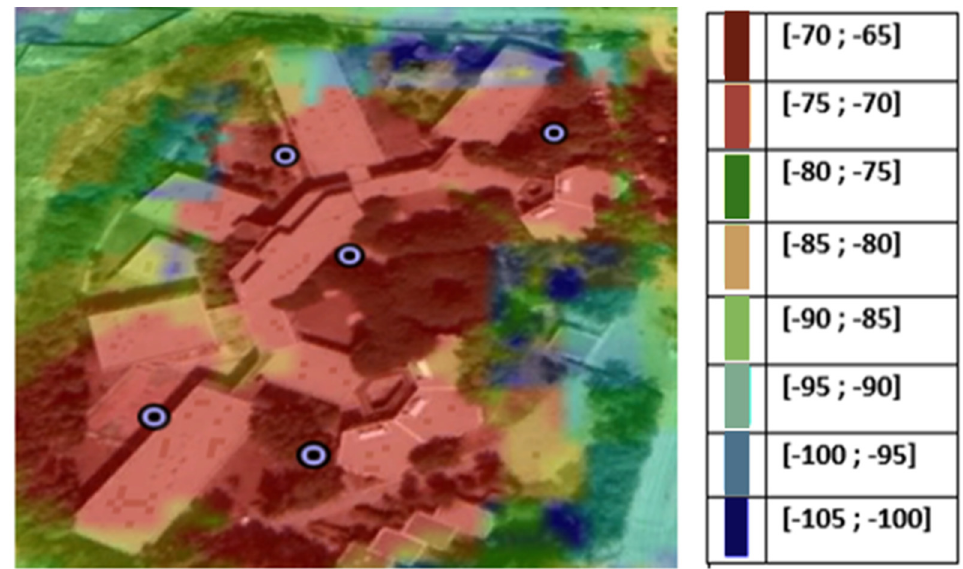
Figure 6. Map showing the signal power coverage (dBm) predicted in ENST campus.